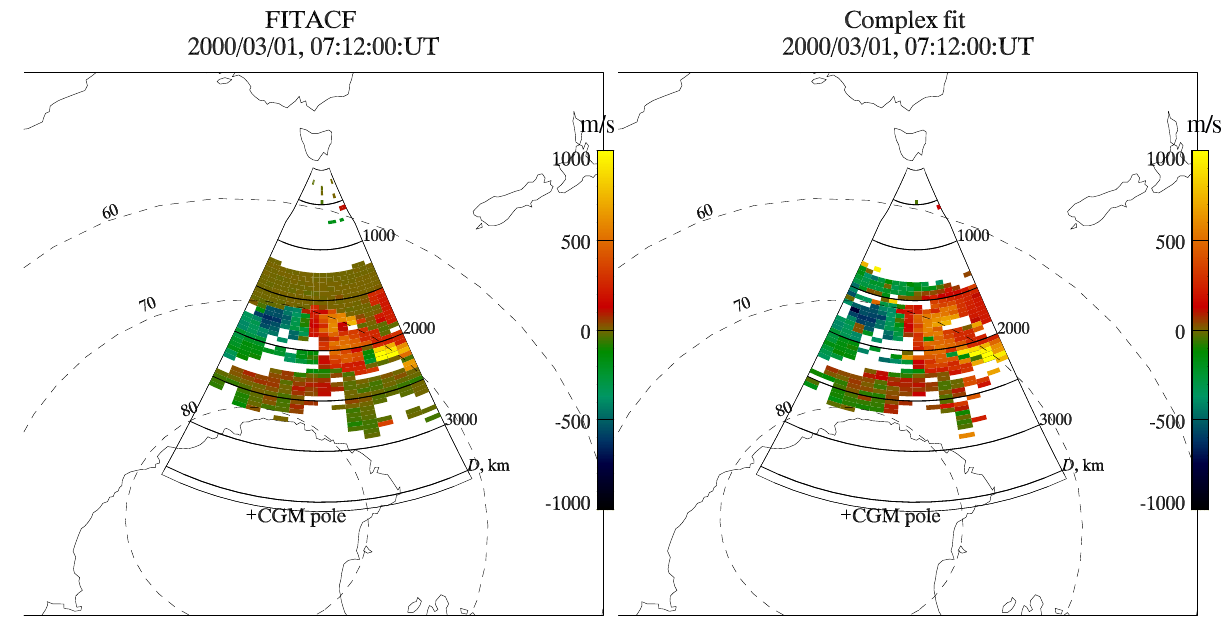
Fig. 6. Spatial distributions of line-of-sight velocity for 07:12–07:14UT 1 March 2000. The left panel shows results obtained for the conventional single-component fitting procedure. The right panel represent the same parameter but estimated for the ionospheric component of the two-component